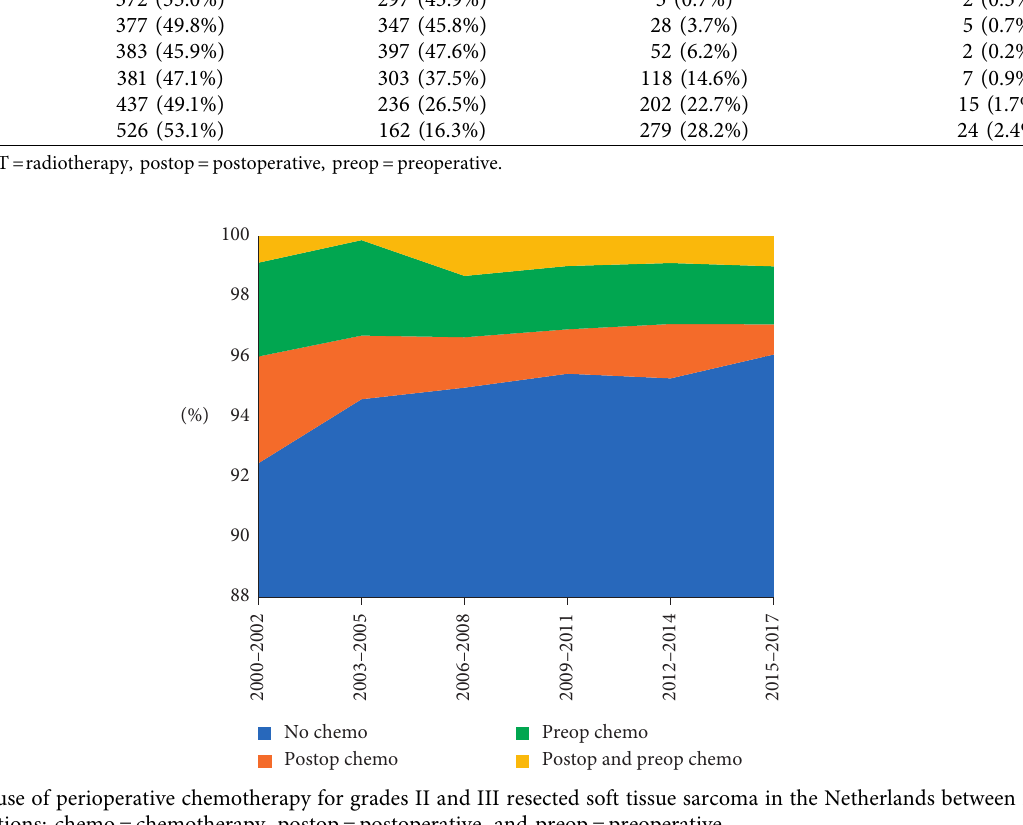
Table 2: The use of perioperative radiotherapy for grades II and III resected soft tissue sarcoma in the Netherlands between 2000 and 2017. No RT Postop RT Preop RT Postop and preop RT